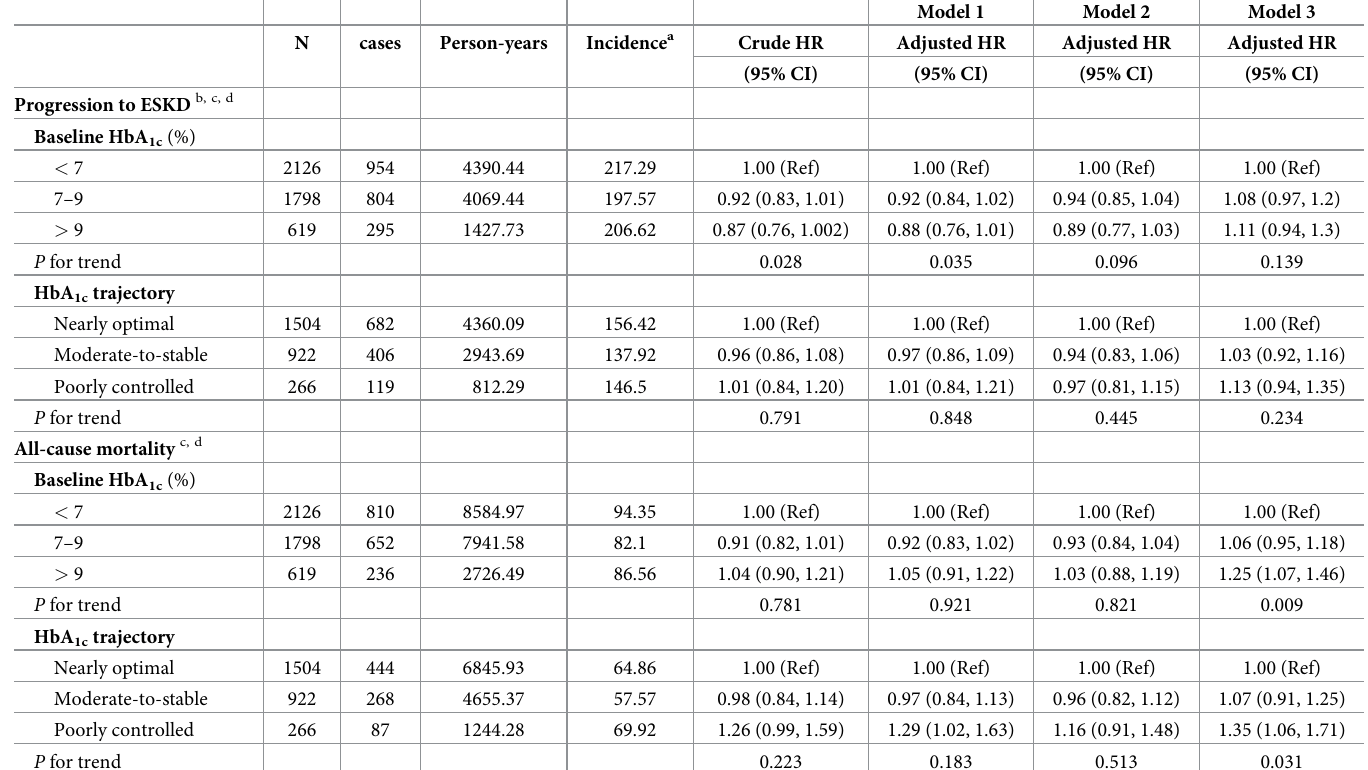
Table 2. Hazard ratios (95% confidence interval) of progression to end-stage kidney disease (ESKD) and all-cause mortality associated with baseline HbA 1c and HbA 1c trajectory